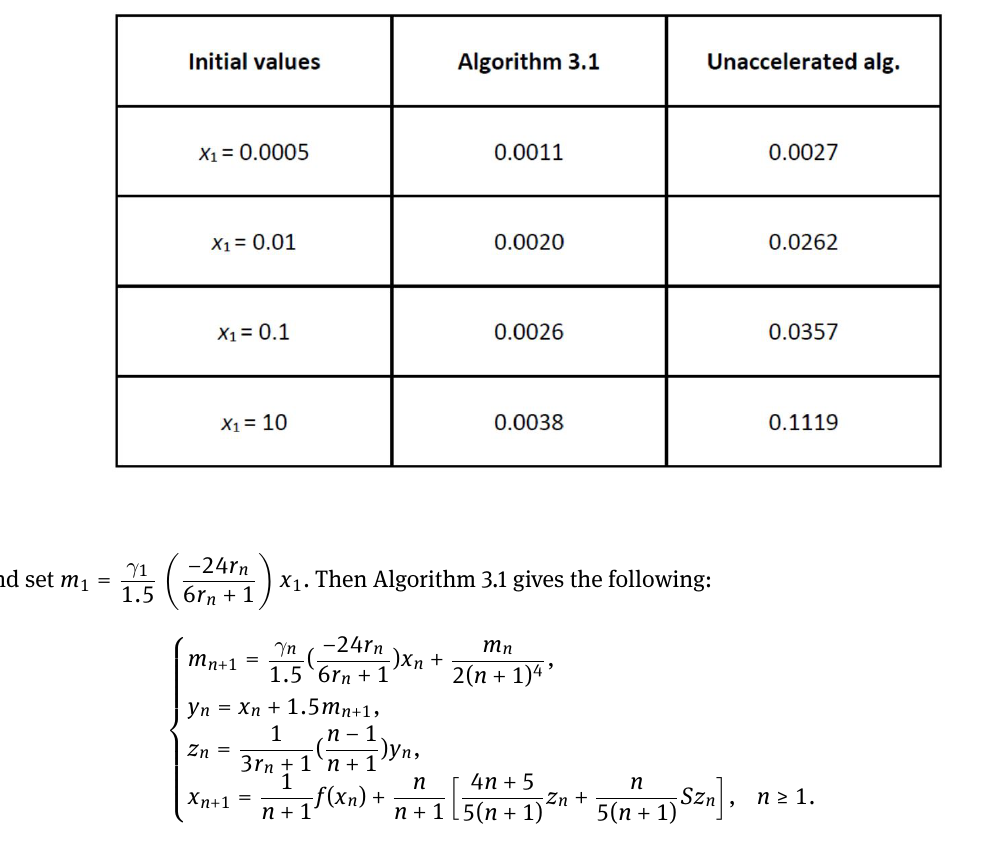
Algorithm 3.1 with its unaccelerated form (i.e. taking β n = 0) and plot the graphs of accuracy against